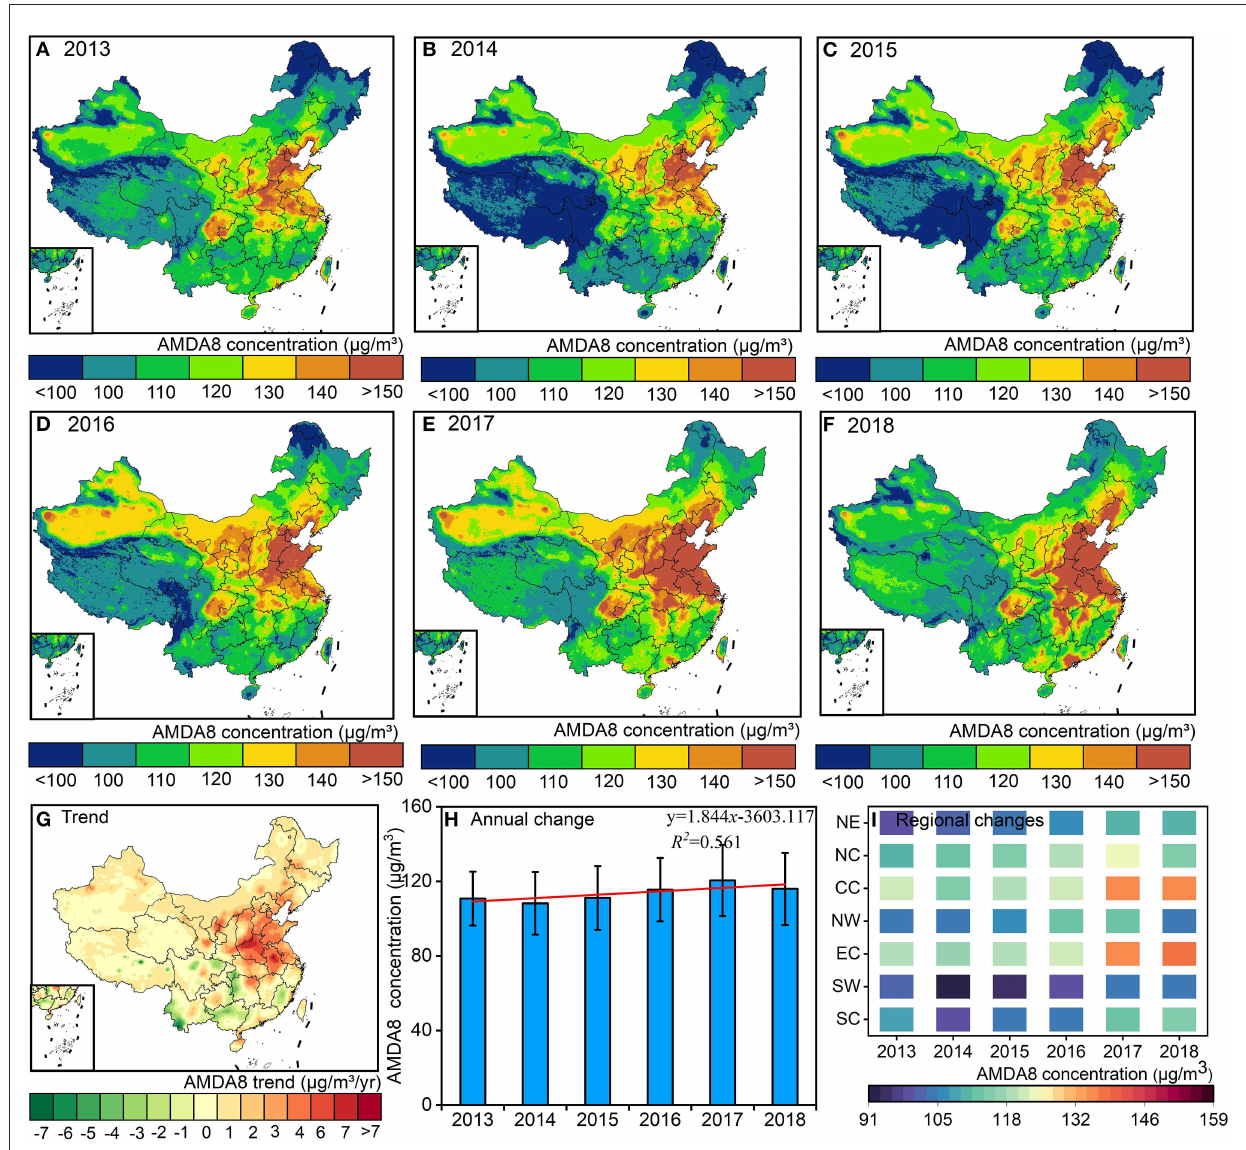
FIGURE3 The spatial distribution and trend of O 3 concentration from 2013 to 2018. Where, (A–F) represents the spatial distribution of O 3 concentration; (G) represents the trend change of O 3 concentration; (H) represents the annual average O 3 concentration variation; (I) shows the annual average O 3 concentration change in different regions of